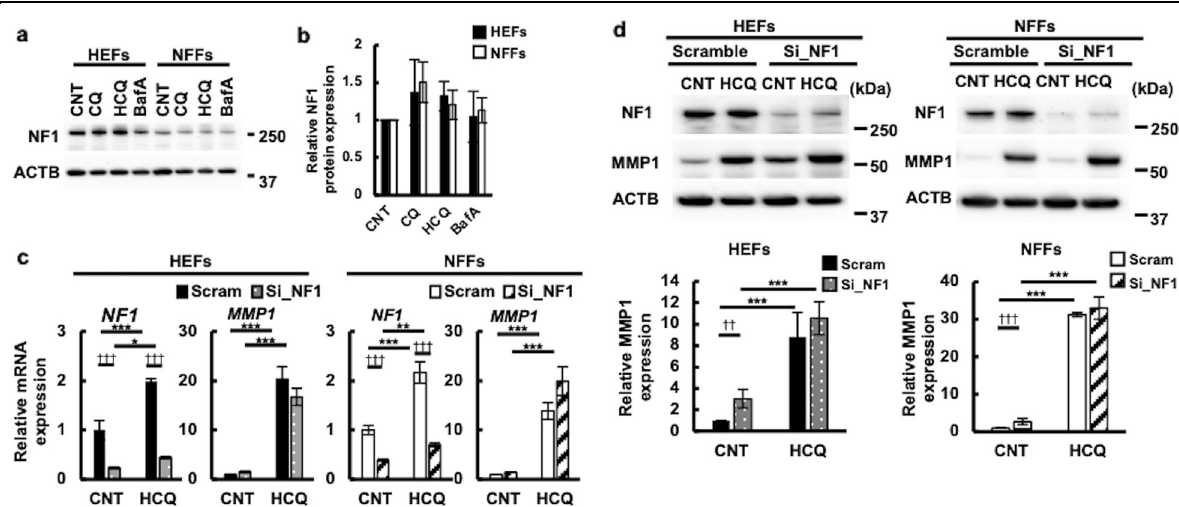
Fig. 4 MMP1-inducing activity of HCQ was not dependent on neuro fi bromin protein. a , b Three cell lines of each HEFs and NFFs were treated with 50 μ M CQ, 50 μ M HCQ, or 5nM BafA for 48h and NF1 expression was analyzed by western blotting. Representative images from three independent experiments are shown in a . NF1 expression was normalized with β -actin and relative expression levels were calculated considering the intensity of vehicle- treated sample as 1 and shown in b . The data represented the mean±SEM of the three independent experiments. c , d The HEFs (KYU168) and NFFs (KYU101) were transfected with scrambled RNA or si_NF1, and treated with 50 μ M HCQ. c NF1 and MMP1 mRNA expression in 24h is shown. The data represented the mean±SD of the three independent experiments. d NF1, MMP1, and β -actin expression was analyzed by western blot and representative images from three independent experiments are shown in the upper part. Relative MMP1 expression is shown in the lower part. The data represented the mean±SD of the three independent experiments. *: compared among drug-treated groups. † : compared with scrambled RNA-transfected group.